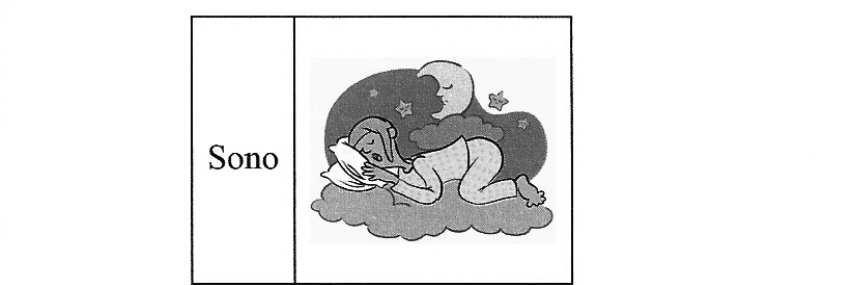
Figura 1 . Apresentação verbal e não verbal dos domínios de vida do ISQV-C: o sono.